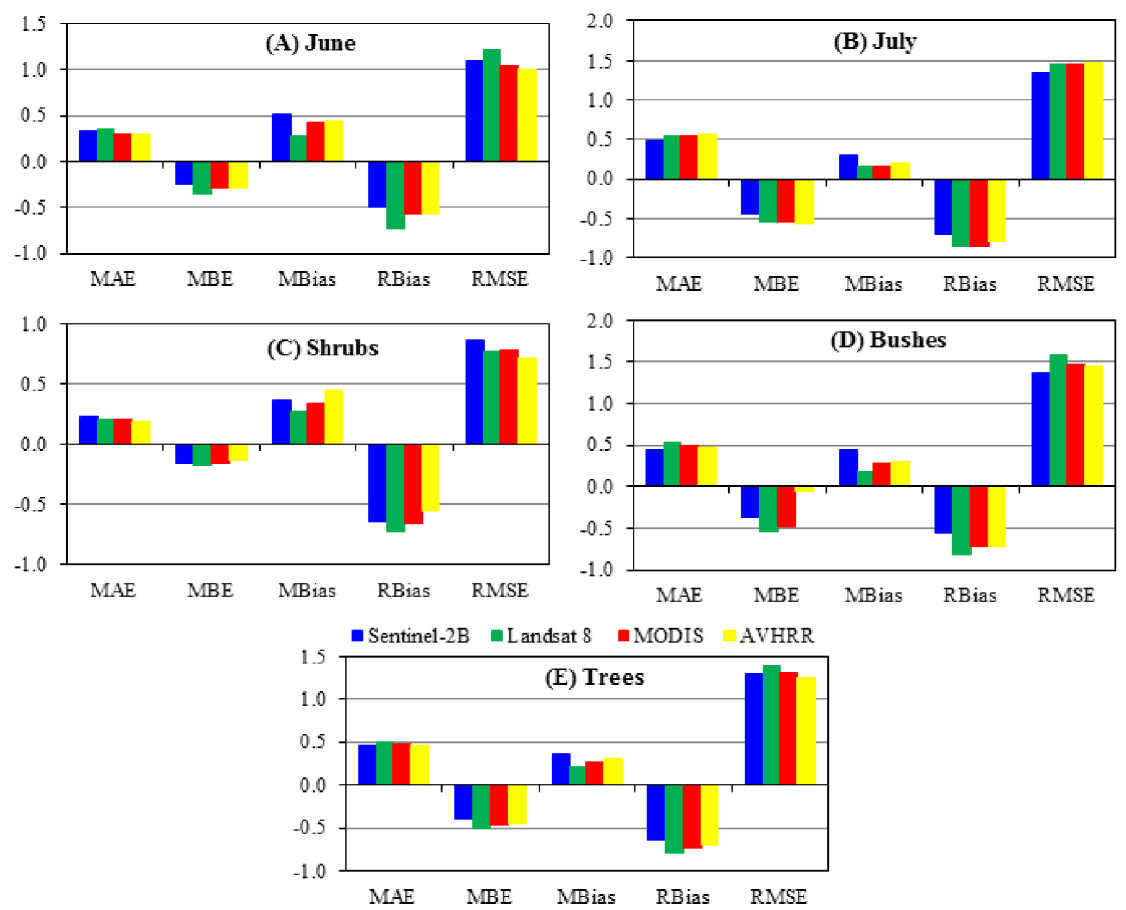
Figure 7. Accuracy assessment of studied sensors in different sampling months ( A , B ) and PFTs ( C , D, E ).